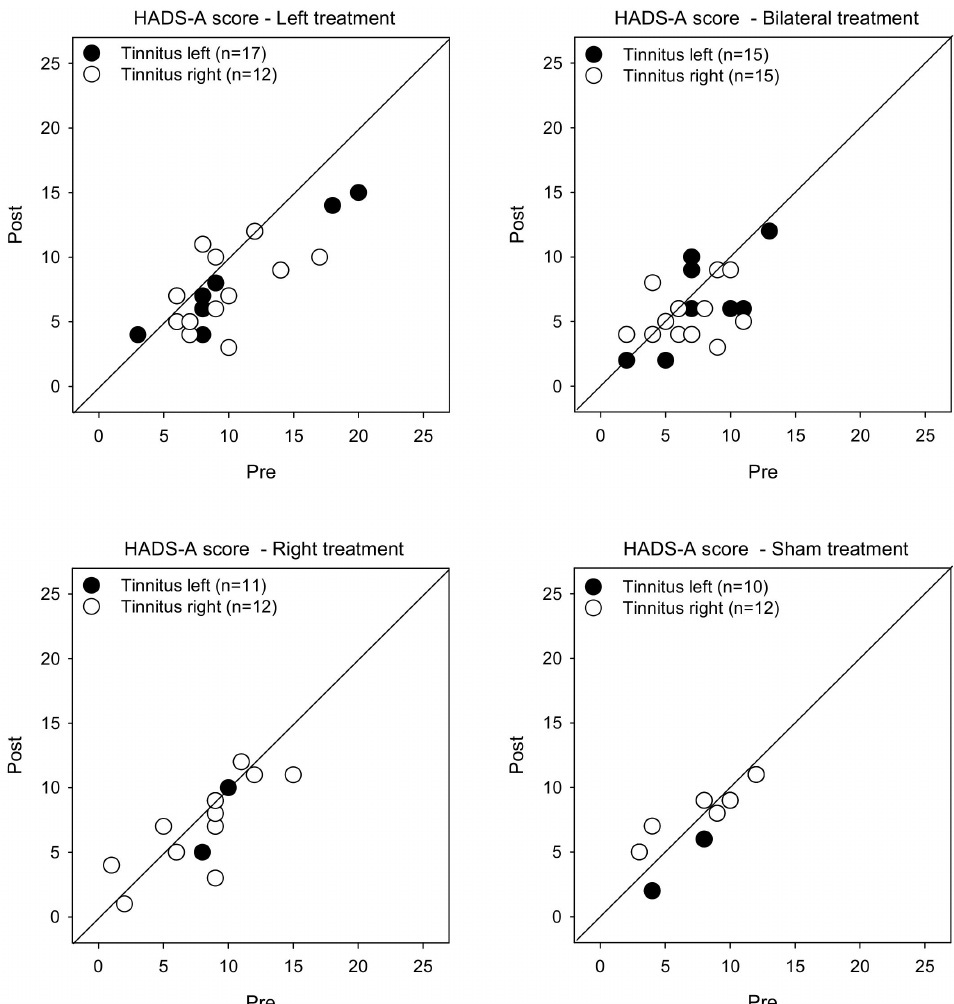
Figure 3. Post-treatment HADS-A scores as a function of pre-treatment scores for the Left, Right, Bilateral, and Sham treatment groups. The filled and open symbols show data for patients with left- or right-sided tinnitus, respectively. Values below the diagonal line indicate reduced anxiety after